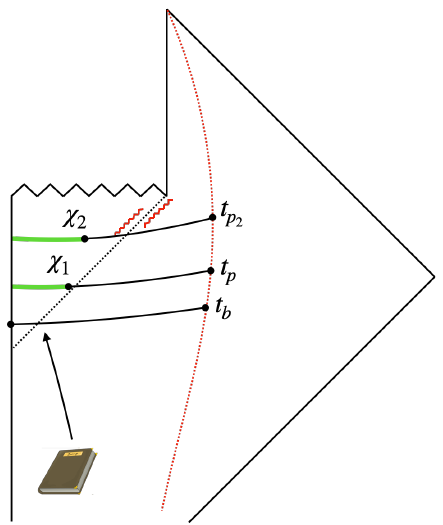
Figure 14 . A Penrose diagram is shown for an evaporating black hole with a large diary thrown into it. We ask when the diary can be reconstructed from the radiation (the fields to the right of the dotted red line). At early times, the entanglement wedge of the radiation is trivial, so the diary cannot be recovered. If the diary was initialized in a pure state, an island (green) forms at t p where the nontrivial extremal surface, χ 1 , becomes smaller than the entropy of the radiation. If the diary was initialized in the maximally mixed state, the island will not form until t because p 2 the generalized entropy includes the entropy of the diary. While the diary cannot be reconstructed with O (1) fidelity until the island forms, the fidelity exponentially increases from its minimal value starting at the earlier time t b